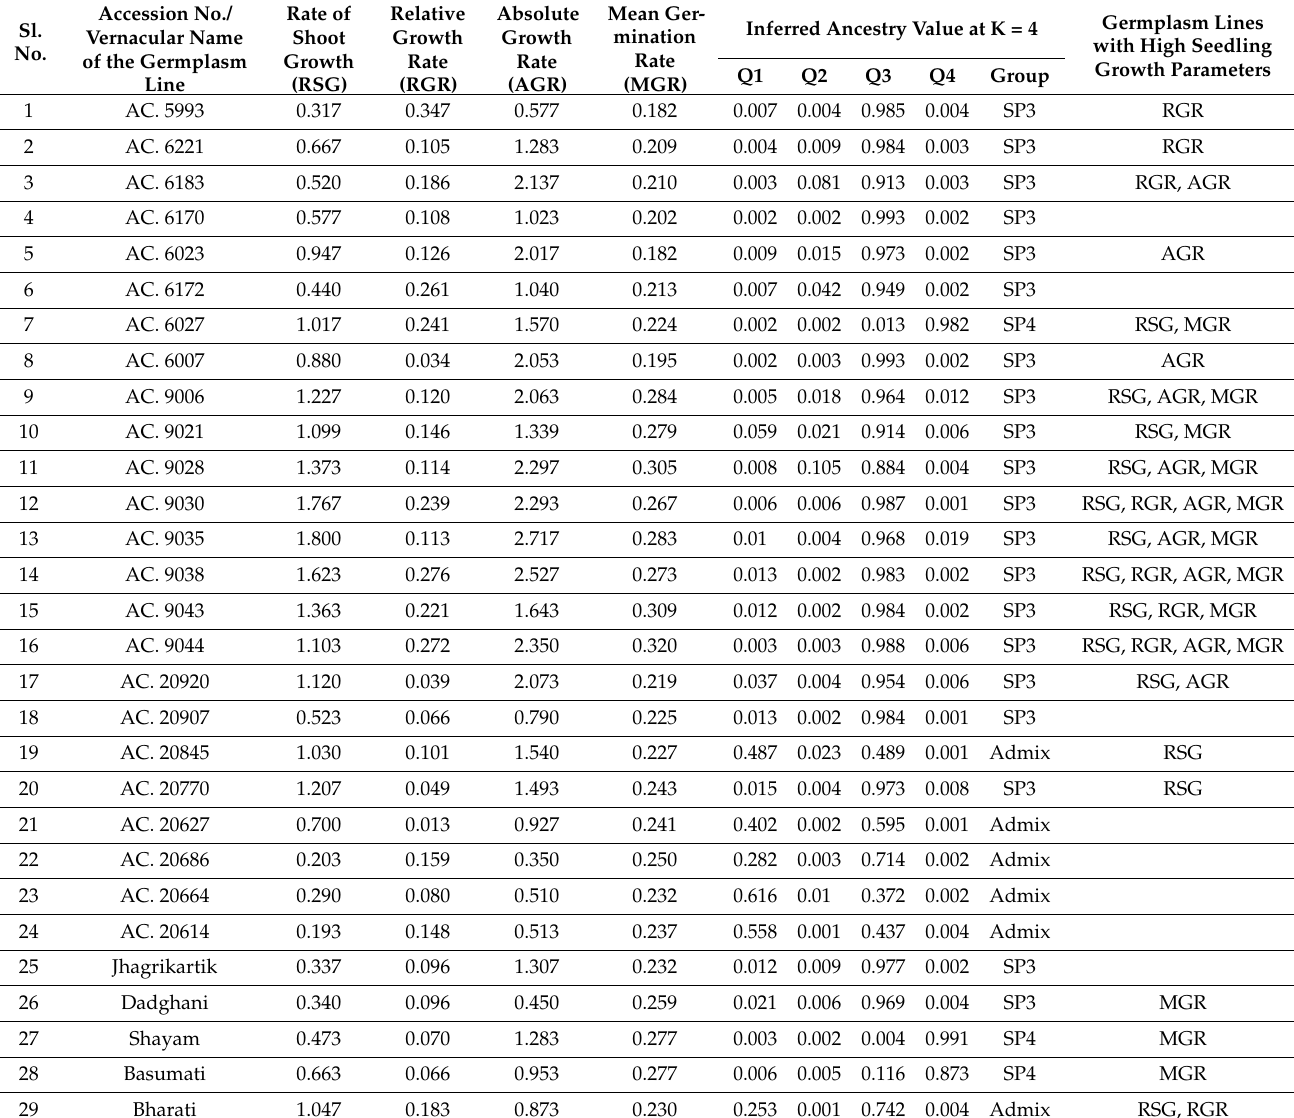
Table 1. Mean estimates of RSG, RGR, ASR and MGR and genetic structure ancestry value at K = 4 in the panel population (n =